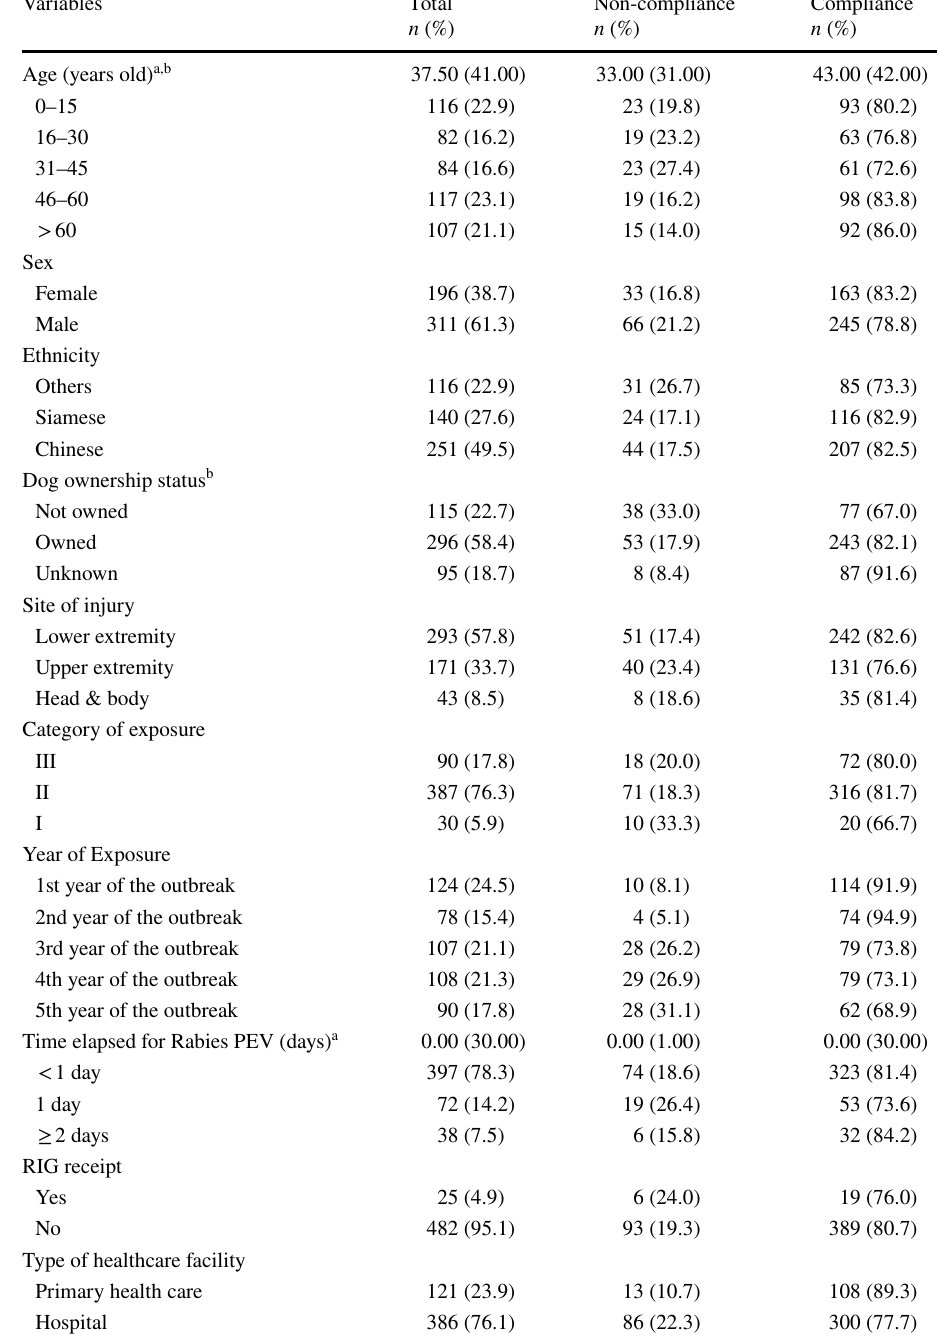
sociodemographic, animal, exposure, and treatment factor of dog bite patients in Perlis between July 2015 and